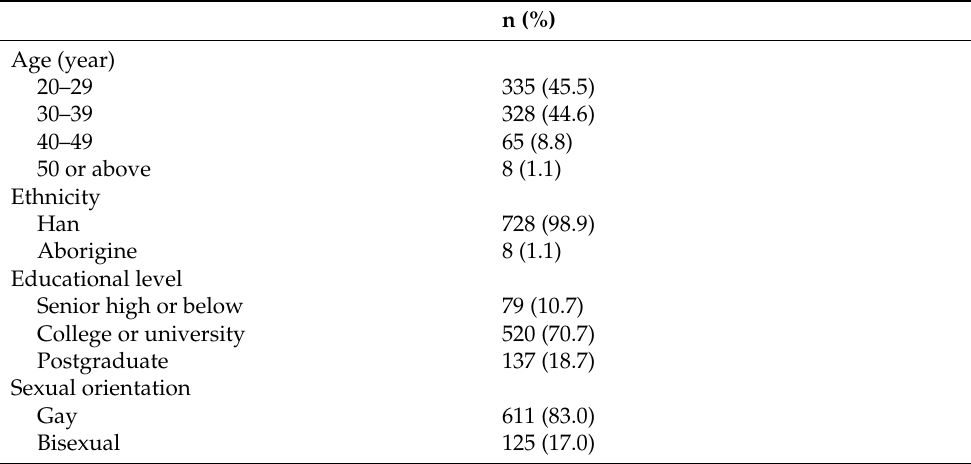
Table 1. Participants’ characteristics (N =